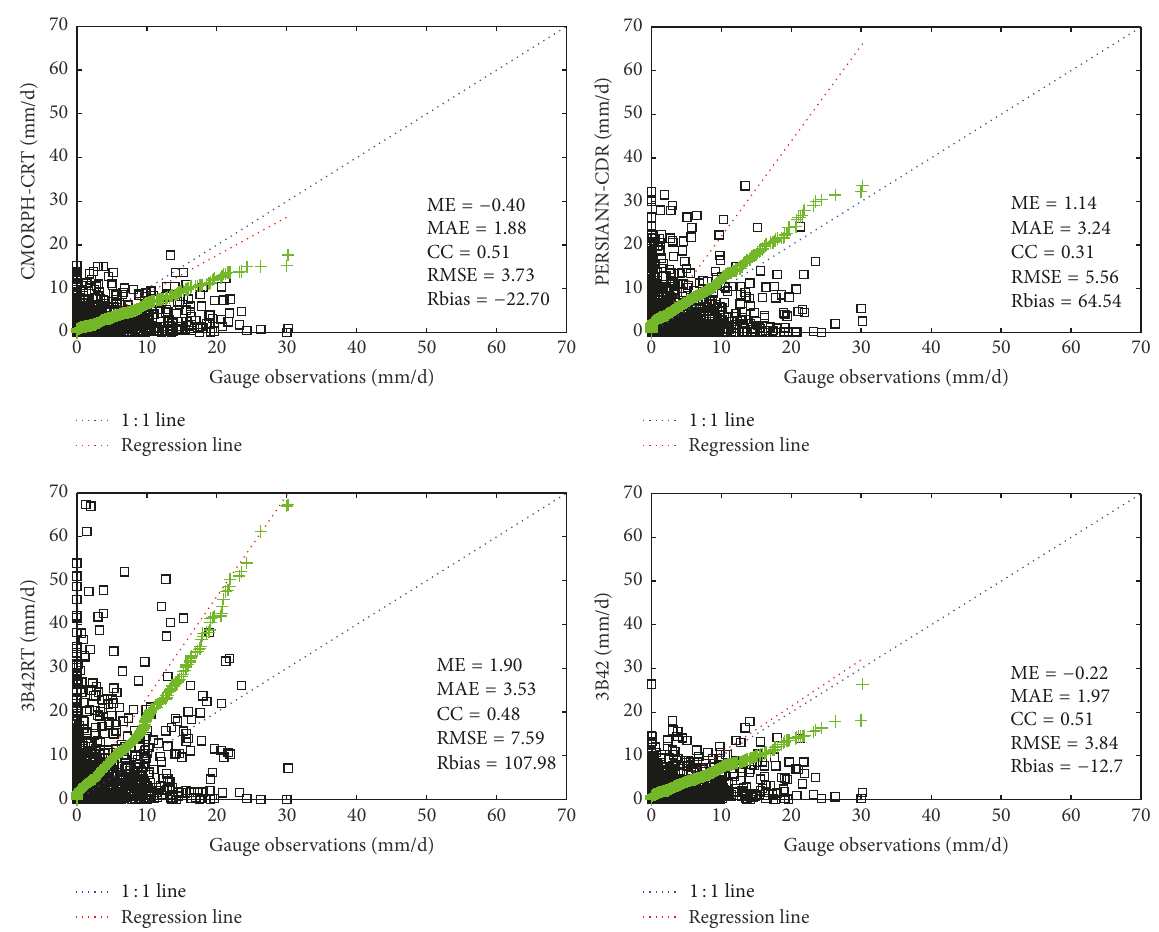
Figure 4: Q-Q plots (green) and scatterplots (black) of basin averaged precipitation from gauge observations versus satellite-based estimates during the period 2008 to